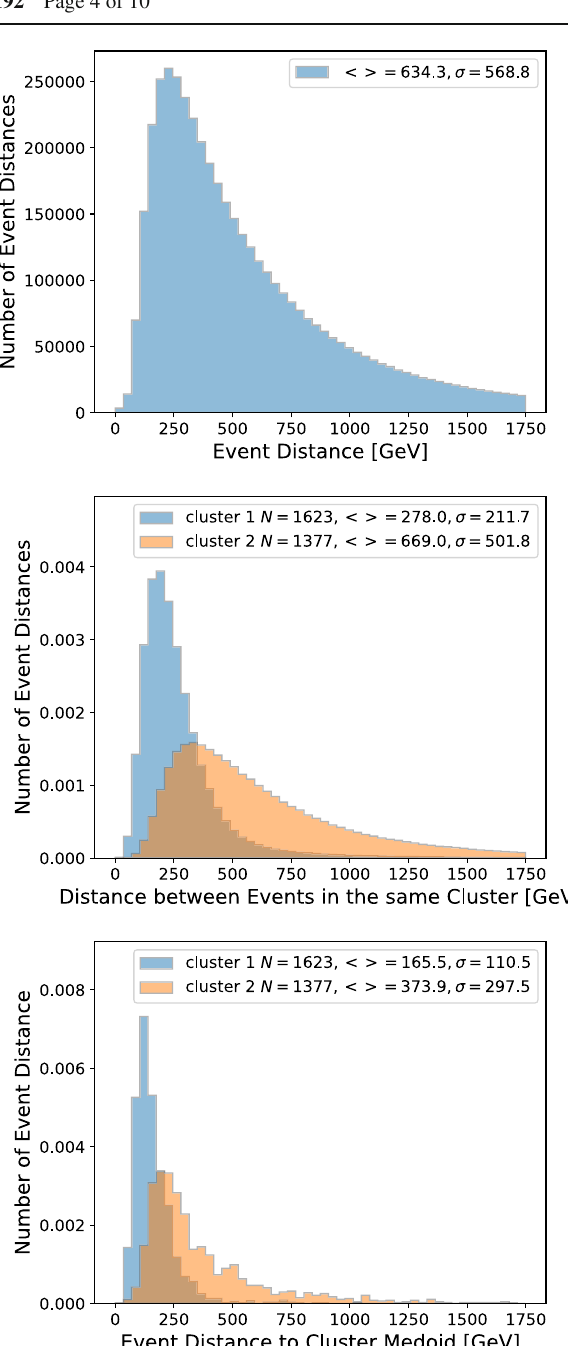
Fig. 2 Event Distances for a sample of 3 k t ¯ tZ simulated events (up) for all pairwise combination of events in the sample, (middle) for pair- wise combination of events belonging to the same cluster and (bottom) between the cluster events and its medoid